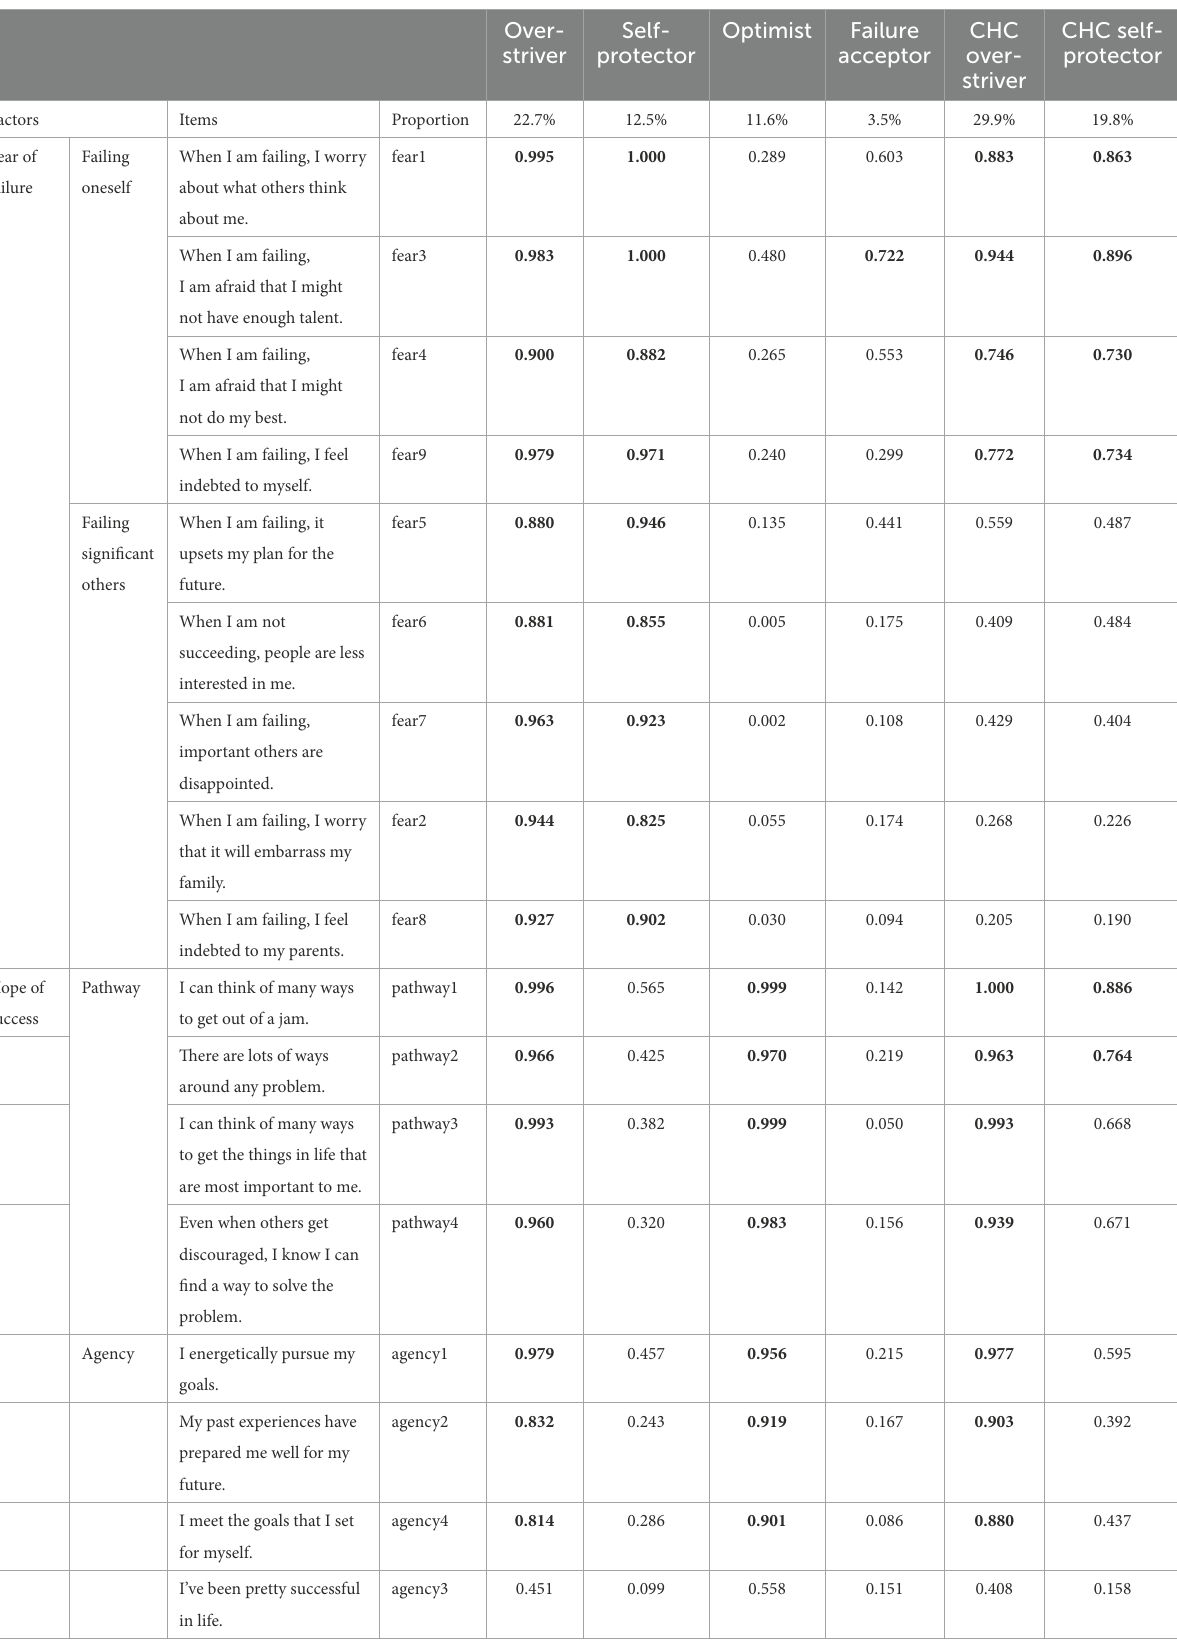
TABLE 2 Conditional probabilities and group proportions of the six observed latent groups.